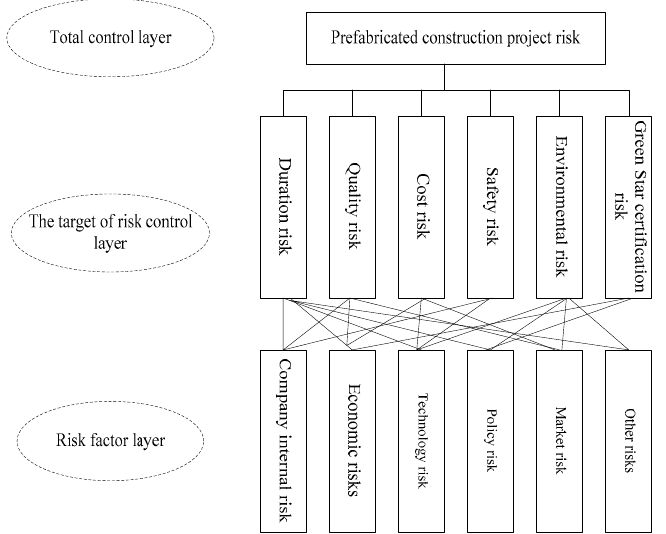
Figure 2. The risk level of the prefabricated construction project from the perspective of developers.